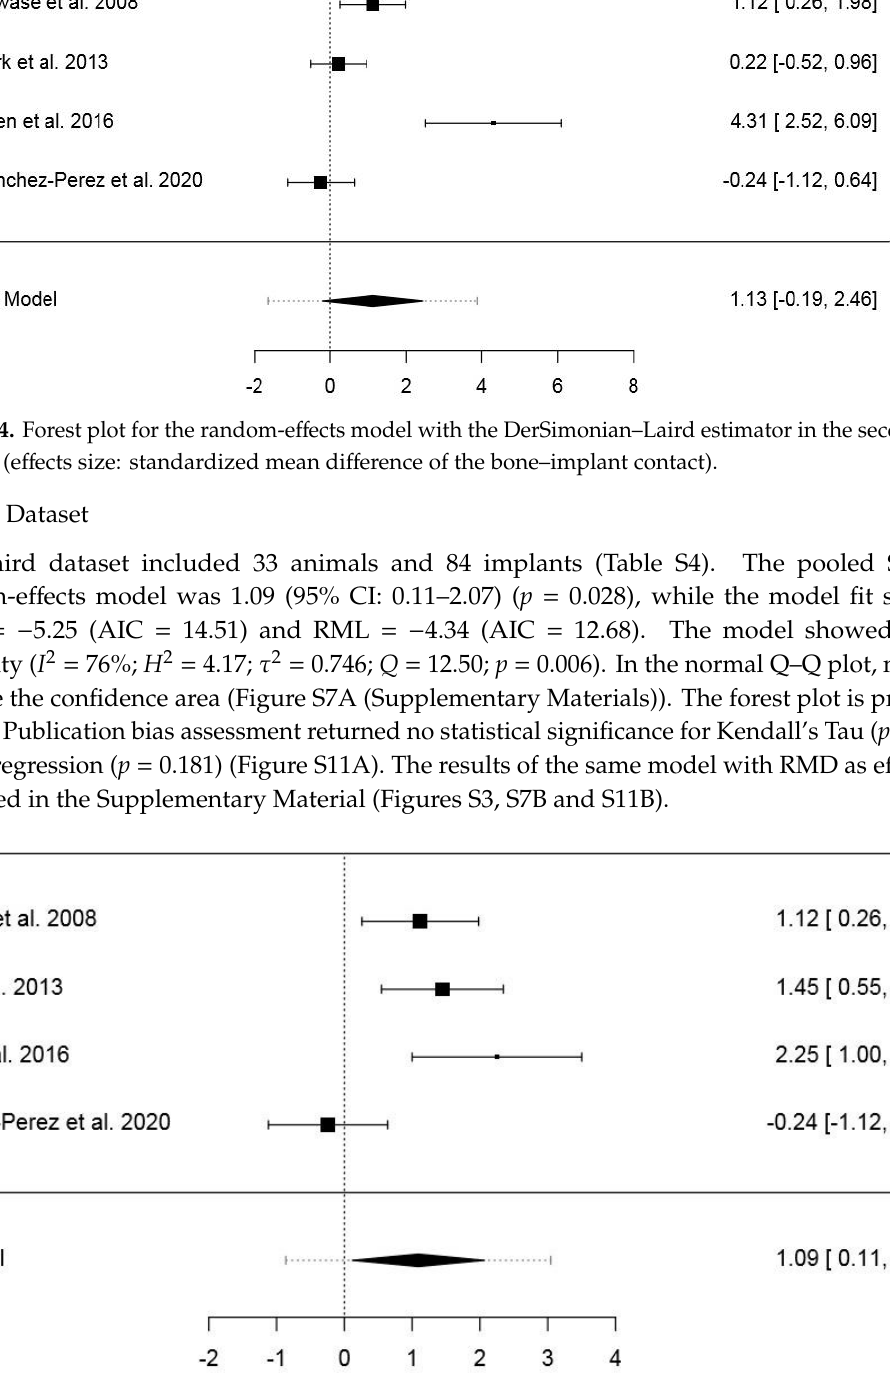
Figure 5. Forest plot for the random-effects model with the DerSimonian – Laird estimator in the third dataset (effects size: standardized mean difference of the bone – implant contact).